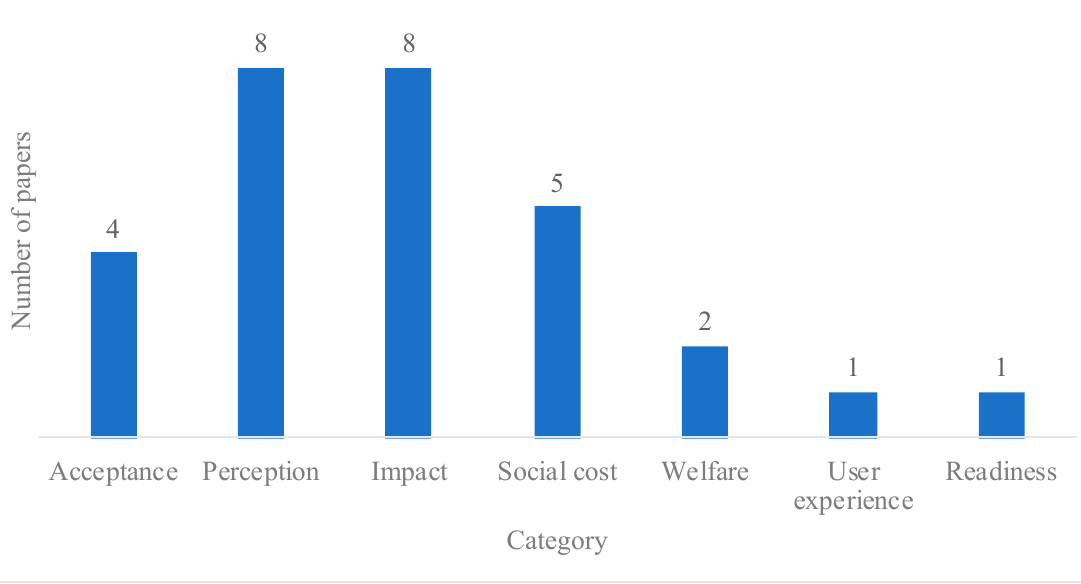
Figure 2. Papers divided in specific categories related to social aspects of EVs.